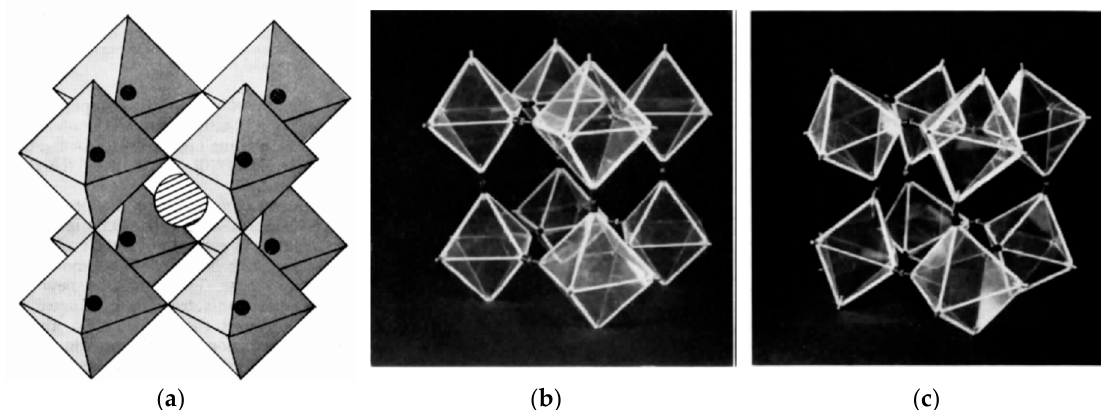
Figure 7. ( a ) The corner linked network of BO 3 octahedra with interstitial A ions. The B ions are shown in solid black circles, while the A ion is shown as striped circle. ( b ) Stereo-photograph of octahedral tilting pattern for a 0 a 0 c + , where the adjacent octahedra along c axis are tilted in phase. ( c ) Stereo-photograph of octahedral tilting pattern for a − b − c − , where the adjacent octahedra along all three axes are tilted in antiphase manner. After Glazer [64] Reprinted from reference [55] DOI: 10.1103/PhysRevB.99.117601, with permission from the American Physical Society.